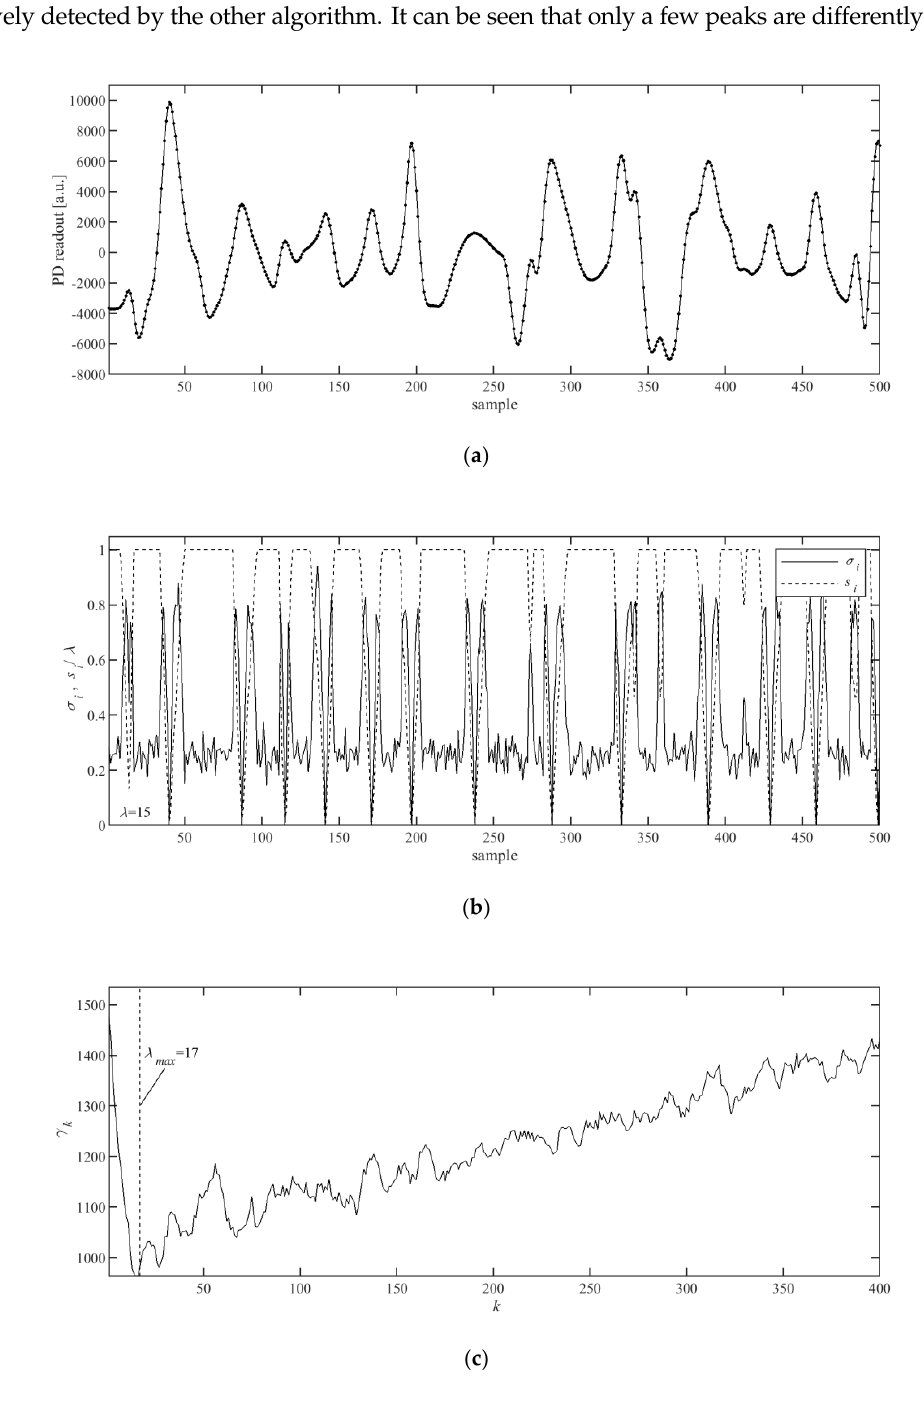
Figure 4. Sample of ( a ) filtered input PPG signal, ( b ) calculated and normalized values of σ i from Equation (5) and s i from Equation (8), and ( c ) calculated values of k from Equation (4 ) . The PPG signal from a wrist is weak, as can be seen in Figure 2c, and when sampled, the situation of a “flat” peak with two equal values for samples t i -1 and t i , as shown in an example in